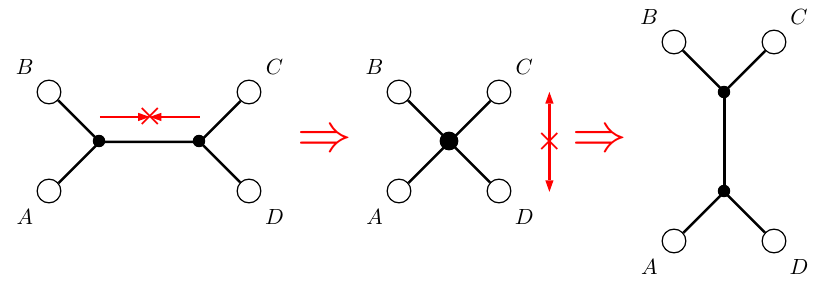
Figure 6 . Planar move operation used in definition